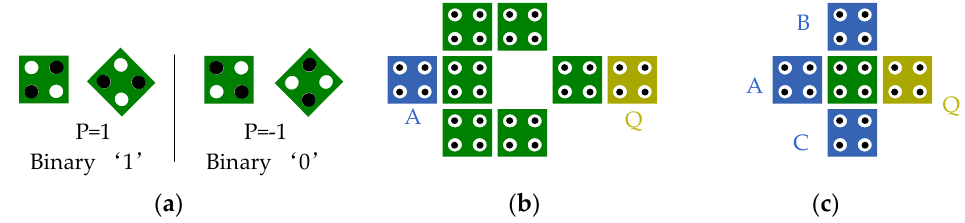
Figure 1. QCA basic units. ( a ) QCA cell (1, − 1), ( b ) inverter, and ( c ) three-input majority gate. A QCA circuit is separated by different clock zones so that all QCA cells in each zone are controlled by the same clock signal and perform specific operations. Figure 2 shows the QCA clock. Switch, hold, release, and relax are four clock phases in a clock. In the switch phase, the cell enters a polarized state according to the state of the drive cell. In the hold stage, the maximum polarity of cells remained unchanged. During the release phase, the cell begins to lose polarity. In the relax phase, the cell is in a non-polarized state. These clocks are 90 degrees out of phase so as to ensure the correct transmission of signals. The cells of the four clocks are represented by four different colors. The blue cell is the input cell and the yellow cell is the output cell.